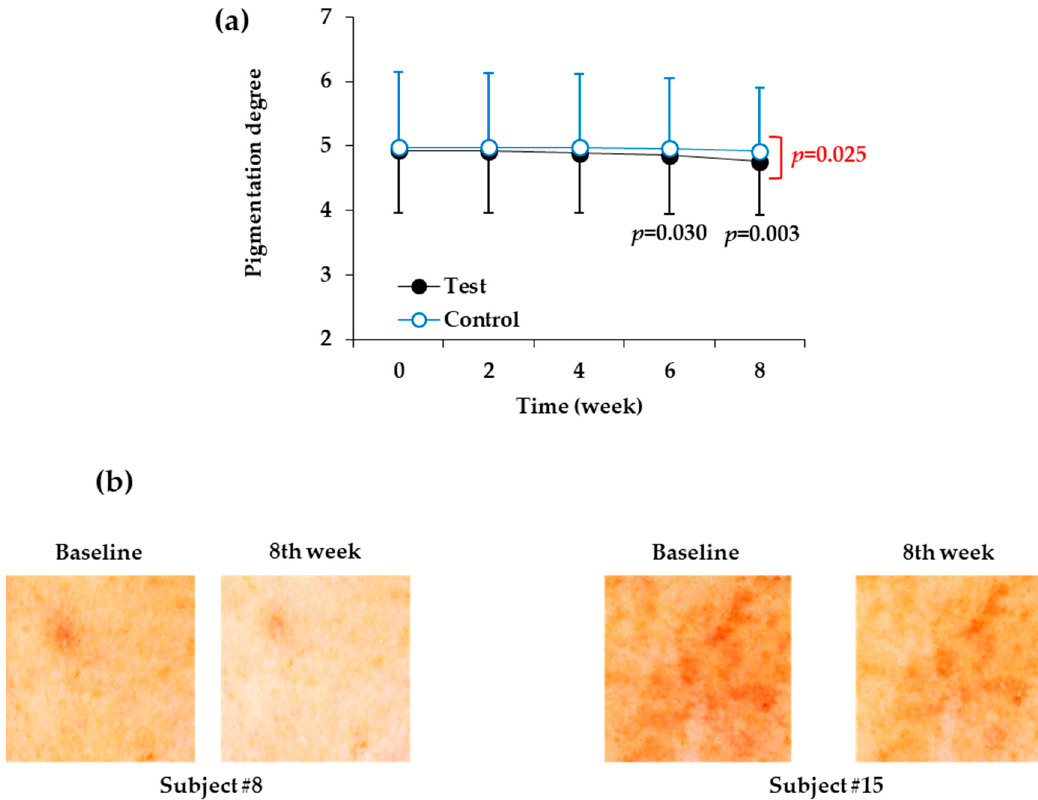
Figure 3. Changes in the visually assessed degree of pigmentation of the facial skin during application of the test and control products. ( a ) Degree of pigmentation was visually assessed by two independent testers and plotted against time (weeks). Data are presented as mean ± SD ( n = 21). The p values of the test group versus the baseline value before the start of the test are shown in black letters if they are less than 0.The p values of the test group versus control group at each time point are shown in red letters if they are less than 0.05. ( b ) Images of the test skin sites to which the test or control products were applied for eight weeks. Representative skin images of human subjects # 8 and #15 before and after the treatment with test product for eight weeks are shown.